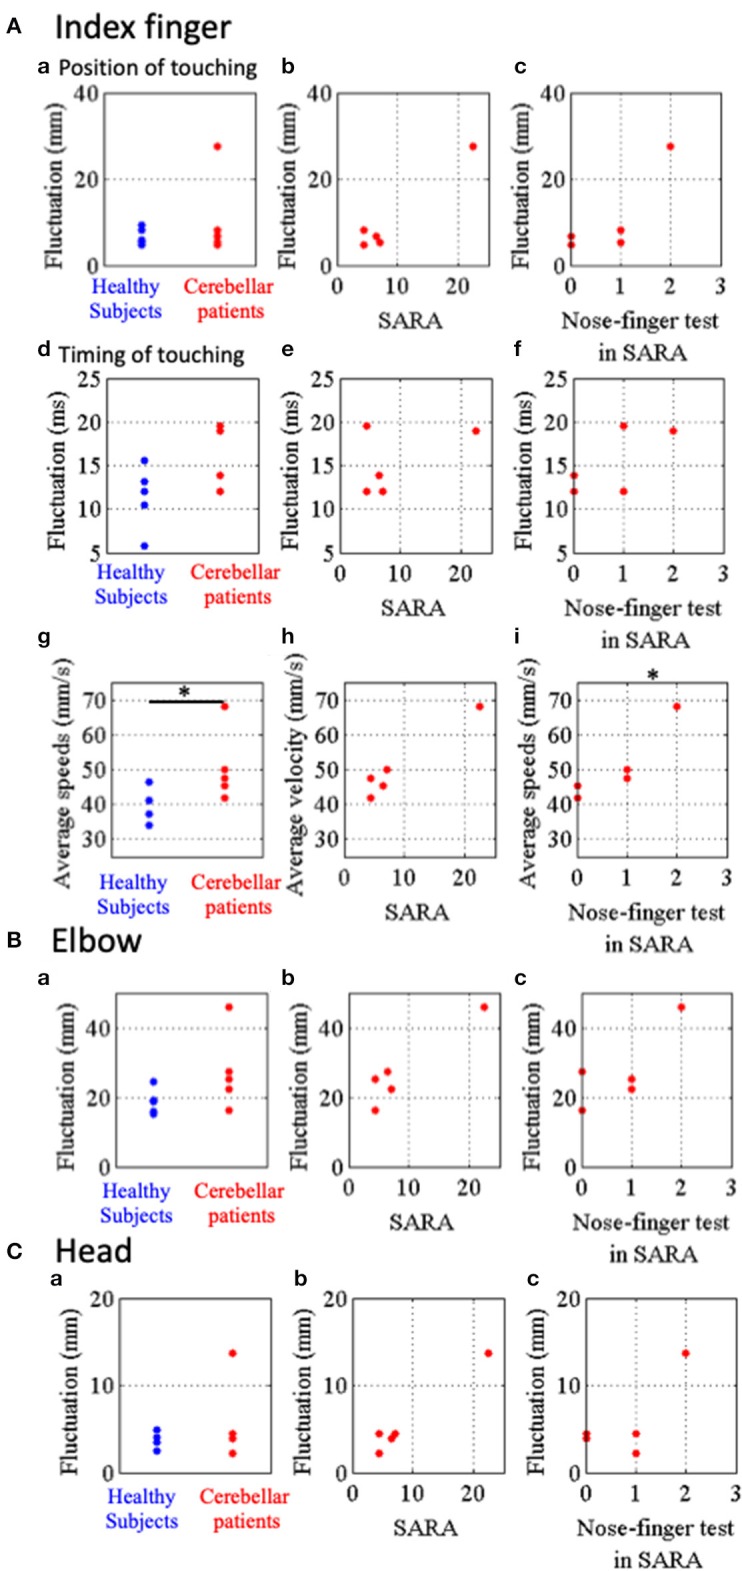
Parameters representing stability of movements of IF, RE and HD in the nose-finger test. (A) Parameters for IF movements. (a) Blue and red dots show fluctuations of IF movements of control subjects and cerebellar patients, respectively. Relationship between the parameters of fluctuation and SARA score (B) or score of the nose-finger test in SARA (C). (d–f) Timing of touching. (d) Blue and red dots show temporal fluctuations of IF movements of control subjects and cerebellar patients, respectively. (g–i) Average speeds of IF movements of control subjects (blue dots) and cerebellar patients (red dots). (B) Fluctuations of RE movements of control subjects (blue dots) and cerebellar patients (red dots). (C) Fluctuations of HD movements of control subjects (blue dots) and cerebellar patients (red dots). *p < 0.05 by Mann–Whitney U-test (g), and *p < 0.05 by Spearman's rank correlation coefficient (otherwise).